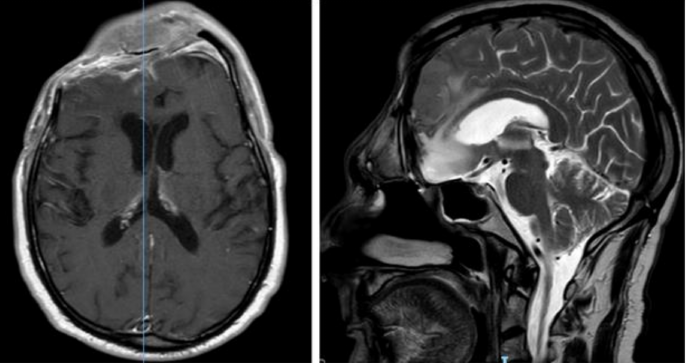
Figure 6. Post-operative brain MRI after evacuation of the epidural empyema, cranial bone flap removal and reconstruction by means of anterolateral thigh